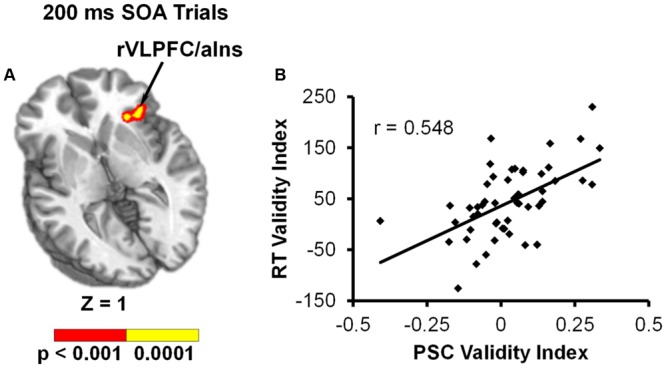
Results from voxel-wise linear regression examining the relationship between RT validity index (invalid – valid) and PSC validity index (invalid – valid) during the 200 ms SOA trials. (A) Shows that functional activation in the right ventrolateral prefrontal cortex/anterior insula (rVLPFC/aIns) was significantly related to behavioral reorienting (p < 0.001: red; p < 0.0001: yellow). Location of the axial (Z) slice is given according to the Talairach atlas. (B) Displays a scatterplot of this relationship.